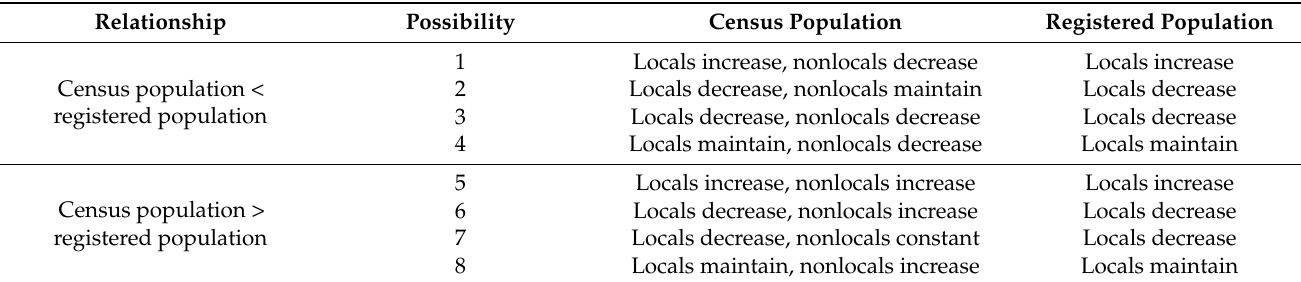
Table 3. Relationship between census population and registered